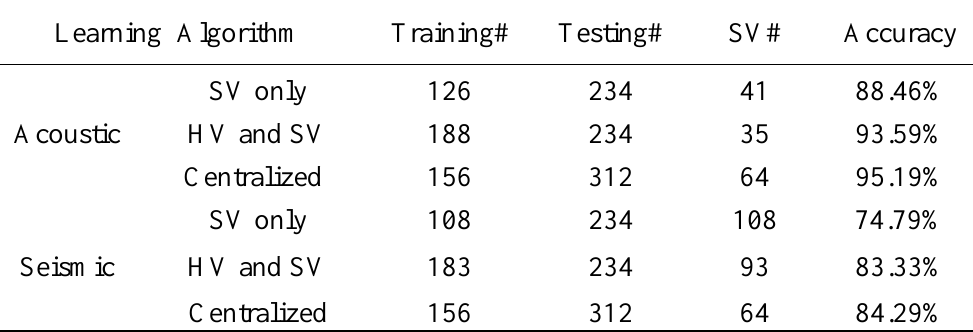
Table 3. Learning performance of different algorithms and